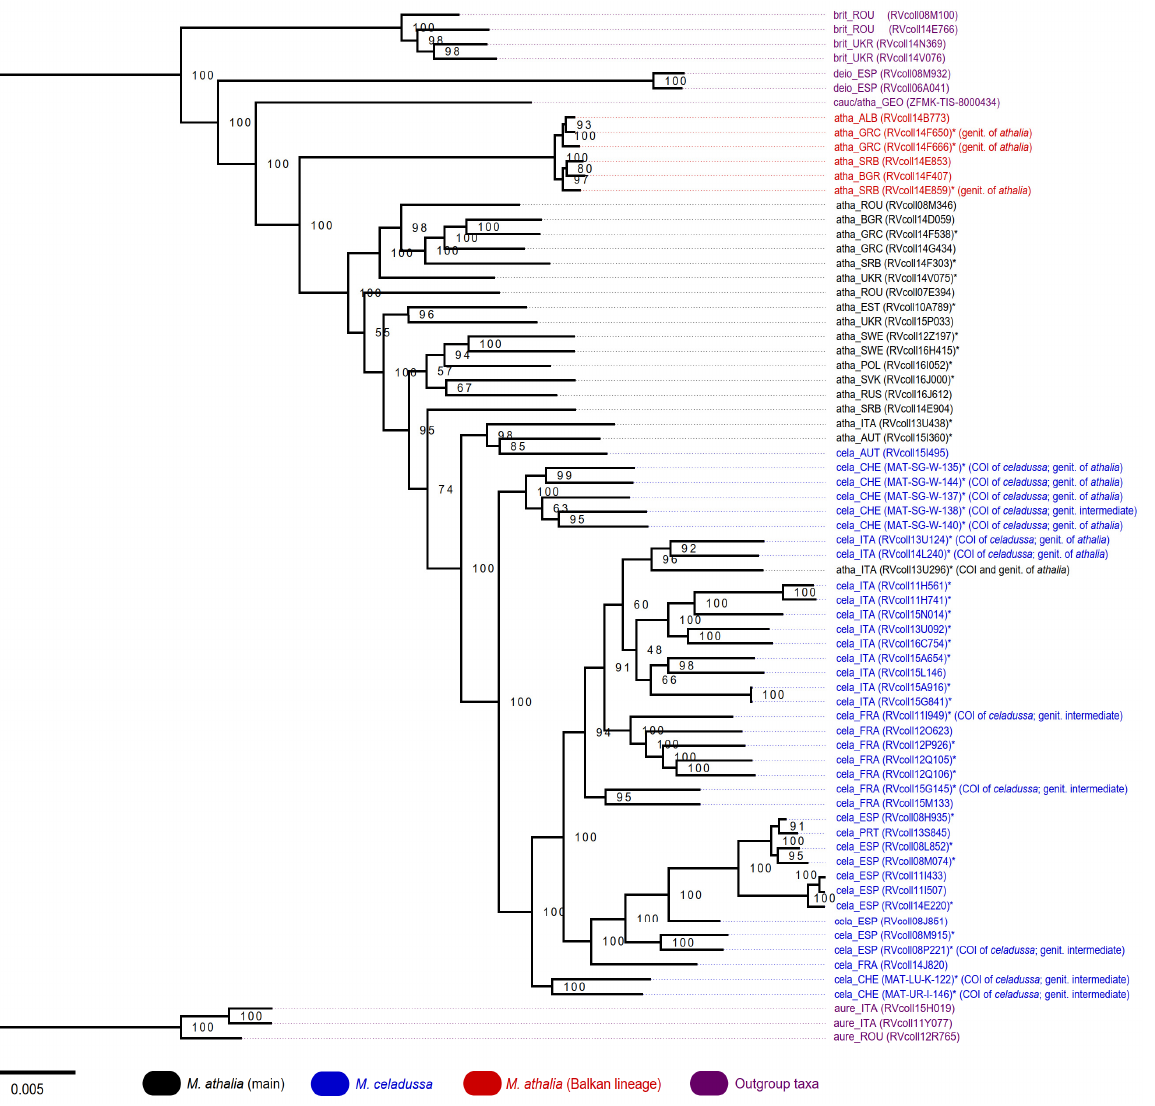
Figure 2. Maximum likelihood tree of M. athalia − M. celadussa inferred based on ddRAD data using reference assembly. Bootstrap supports are given at each node. The tree is rooted on M. aurelia . Asterisks indicate specimens examined for morphometrics.